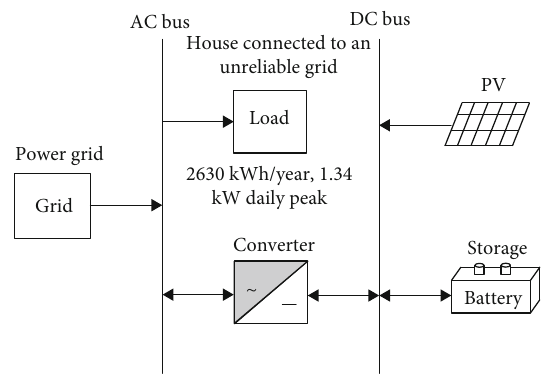
Figure 22: Schematic diagram for the unreliable grid with the PV system